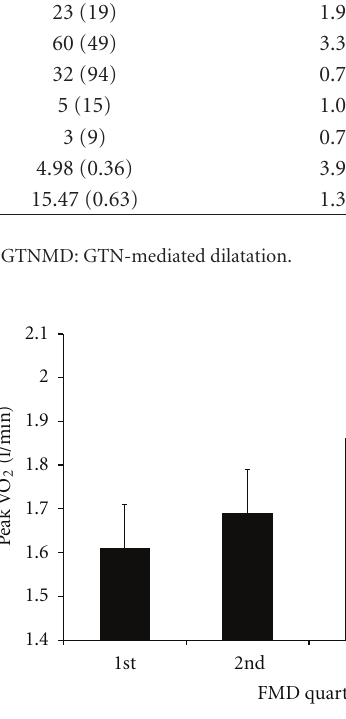
Figure 1: The relationship between endothelial function (quartiles of flow-mediated dilatation: FMD) and peak oxygen uptake (Peak VO 2 ), adjusting for vessel size, age, and body mass